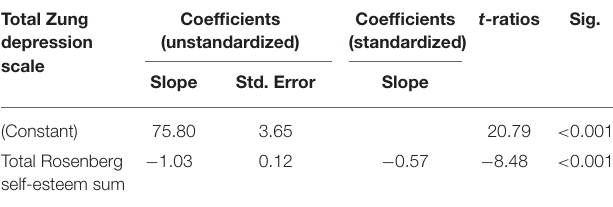
TABLE 3 | Linear regression analysis between self-esteem and depression levels. TABLE 4 | Linear regression analysis between self-esteem and depression-gender wise comparison.